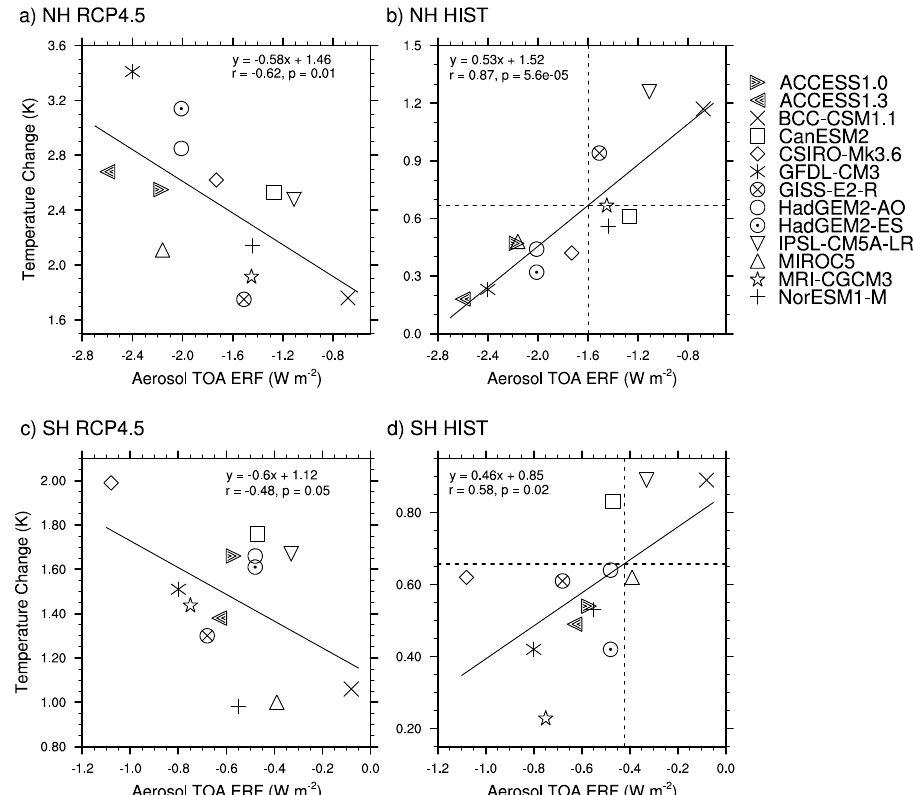
Fig. 12. Changes in hemispheric-mean surface-air temperature from CMIP5 models plotted against (2000 relative to 1850) hemispheric- mean aerosol ERF diagnosed from fixed-SST simulations: (a) NH RCP4.5, (b) NH historical simulations, (c) SH RCP4.5, (d) SH historical simulations. Also shown in each panel are the regression line, the equation for the regression line, the correlation and the level of significance. The dashed horizontal lines in panels (b) and (d) show the observed 1850–2005 hemispheric-mean warming from HadCRUT4, and the dashed vertical lines show the “top-down” estimate of aerosol ERF implied by the intersection of the horizontal lines with the regression